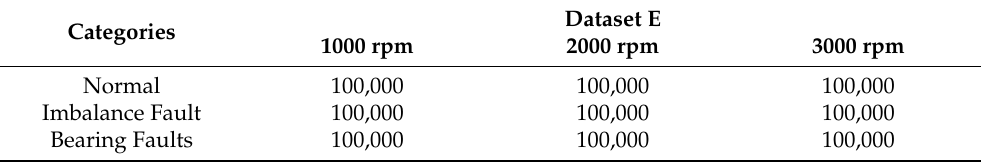
Table 3. The categories and sequence length of the dataset E.